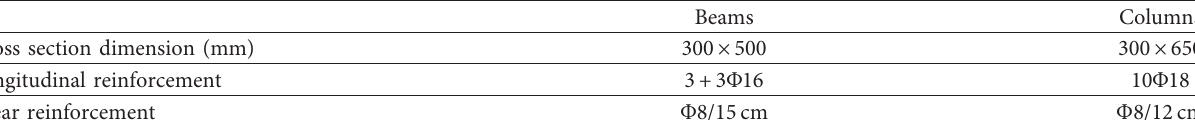
Table 2: Main design details of the reference structural